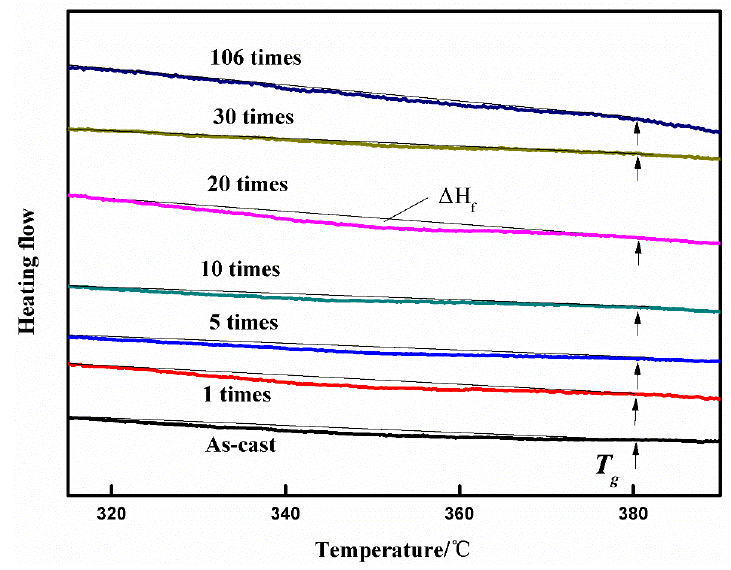
Figure 7. Enlarged image of the DSC scanning curves at low temperatures (arrows indicate T g ).